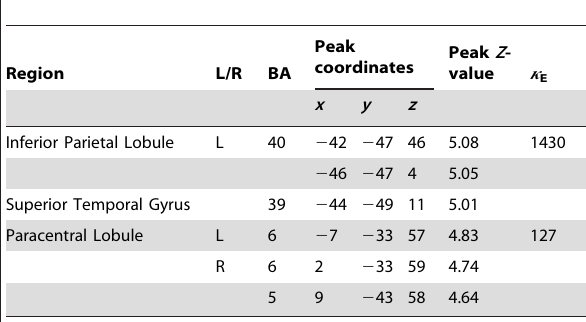
Table 1. Regions showing increased activity in the arms- crossed condition (Crossed L and Crossed R) compared to the uncrossed condition with the participants’ eyes closed (EC) and open